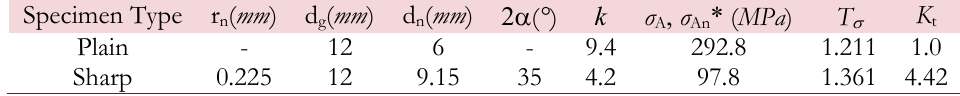
Table 1: Summary of the experimental results generated under fully-reversed CA loading